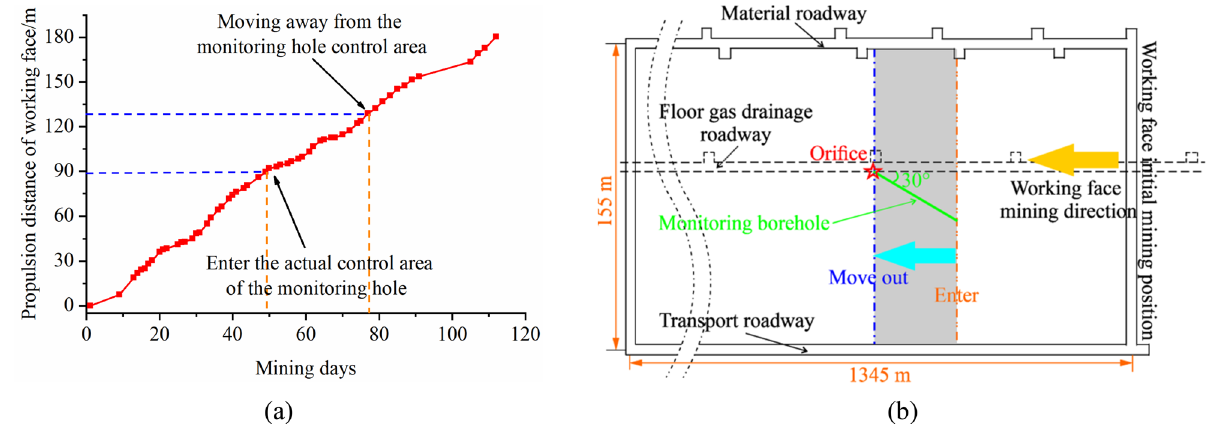
Figure 5. Relationship curve between data collection and mining position of working